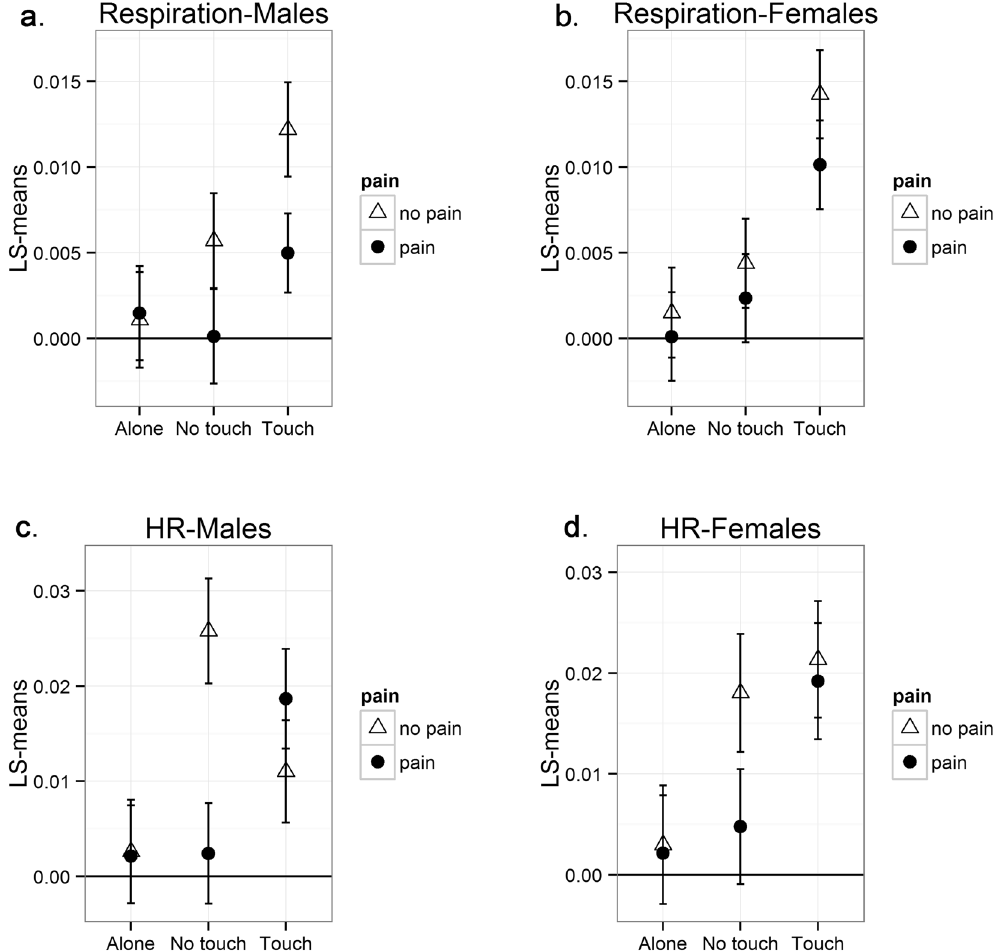
Figure 2. Results of the Coupled Linear Oscillator (CLO) Model for heart rate and respiration. For the sake of simplicity, results are presented as absolute values. The Y-axis presents models based on the least squares (LS) means of each experimental condition, expressing the level of physiological coupling in different experimental conditions. Zero represents a case without interpersonal coupling, while scores that differ from zero indicate interpersonal